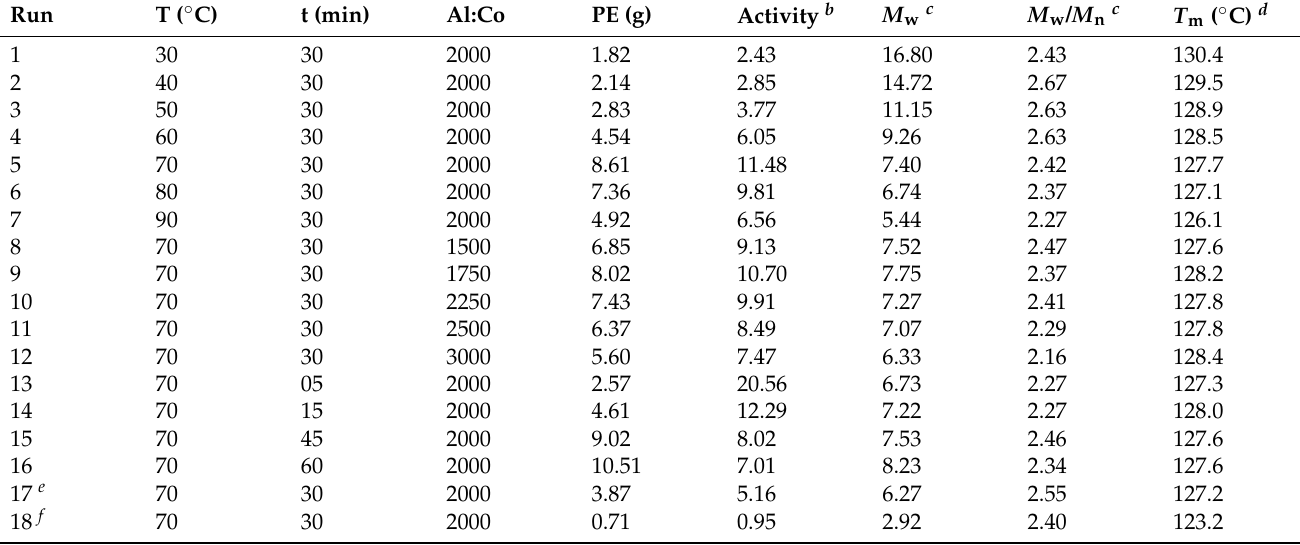
Table 2. Optimization of the polymerization conditions using Co1 /MAO a